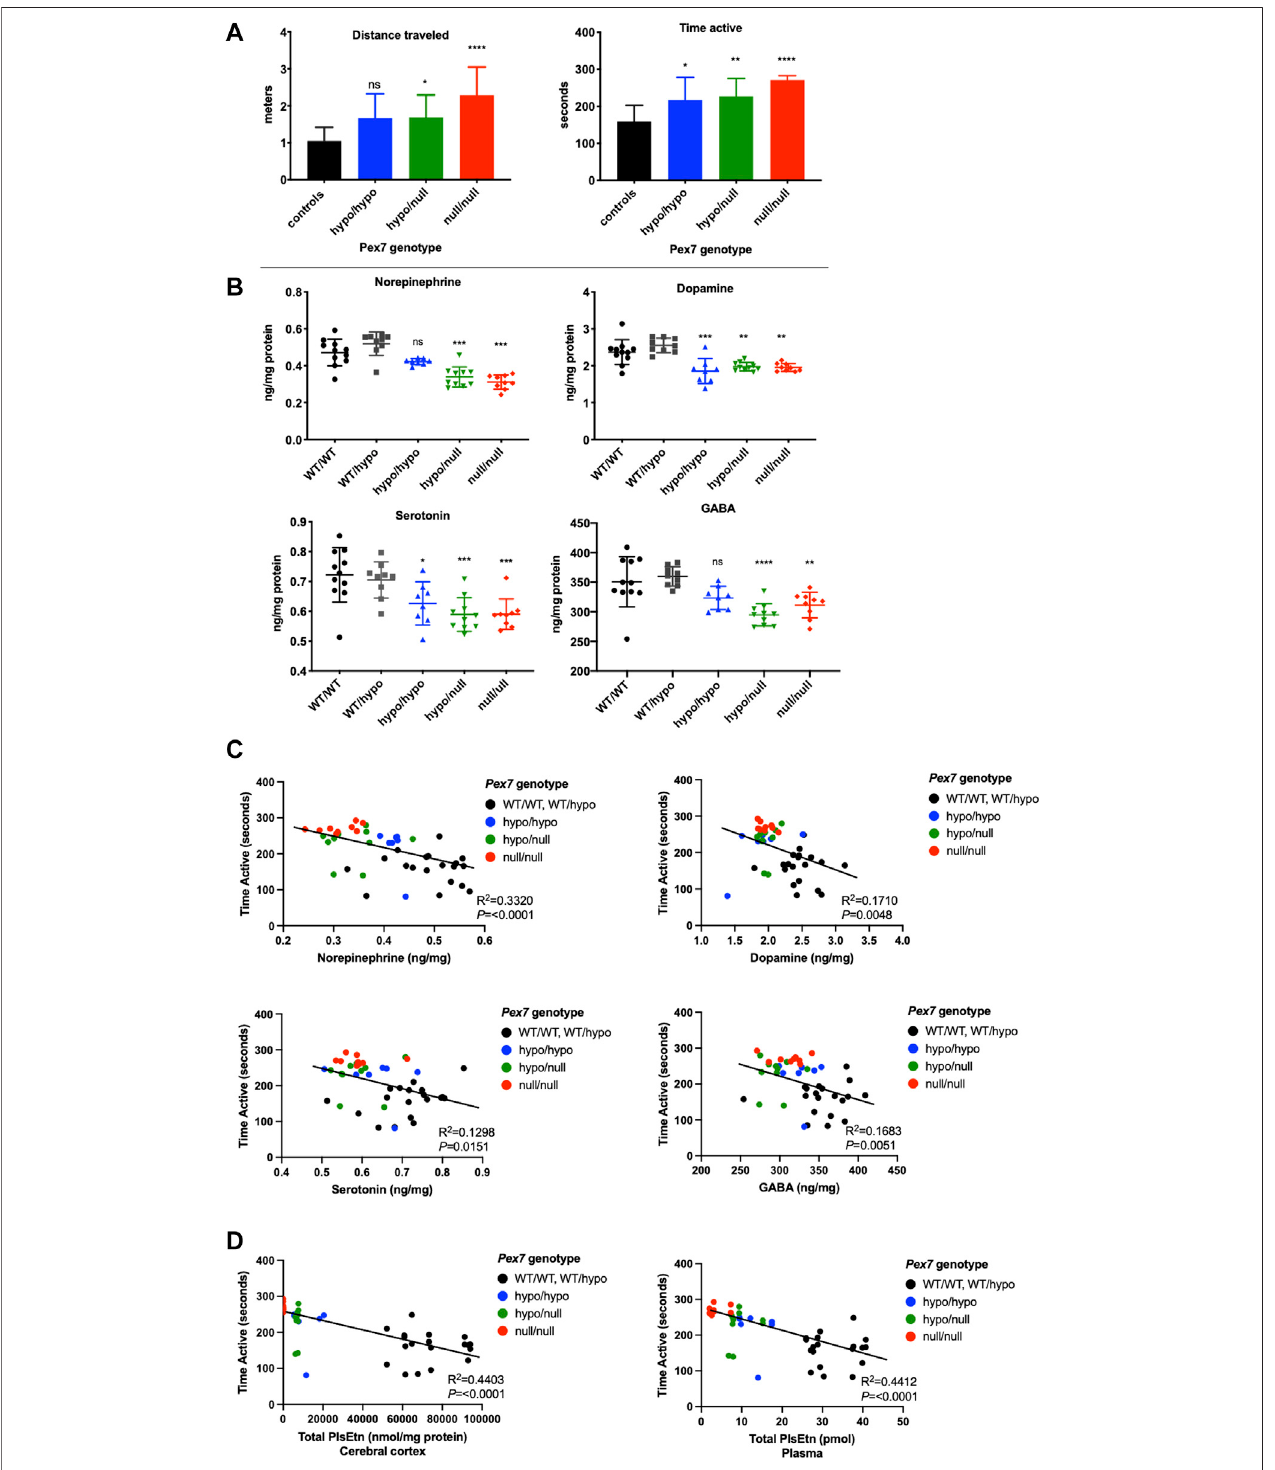
FIGURE 10 | Brain neurotransmitter de fi cits correlate with activity levels in Pex7 de fi cient mice. A signi fi cant increase in activity levels of a subset of Pex7 de fi cient mice is con fi rmed before neurotransmitters analysis (A) . A signi fi cant reduction in dopamine, serotonin, norepinephrine and GABA neurotransmitters is observed in cortical brain tissues from Pex7 de fi cient mice compared to littermate controls ( Pex7 WT/WT and Pex7 WT/hypo ) (B) . The hyperactive phenotype in Pex7 de fi cient mice is inversely correlated with brain neurotransmitter levels (C) and total PlsEtn levels in cerebral cortex as well as plasma (D) . Bars represent group means ± SD. ns: nonsigni fi cant, * p < 0.05, ** p < 0.01, *** p < 0.001, **** p < 0.0001 ( n = 8 – 10 per genotype).